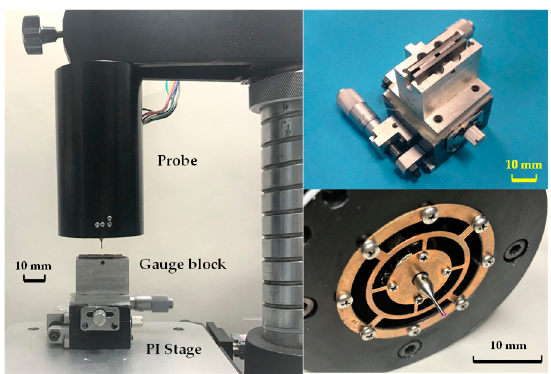
Figure 9. The probe and experimental setup.